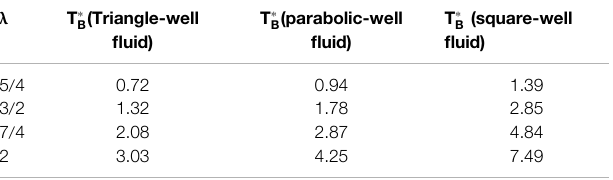
TABLE 1 | Reduced Boyle temperatures T p B ≡ k B T B / ε (up to three signi fi cant fi gures) of triangle-well, parabolic-well, and square-well fl uids for various values of the range λ .